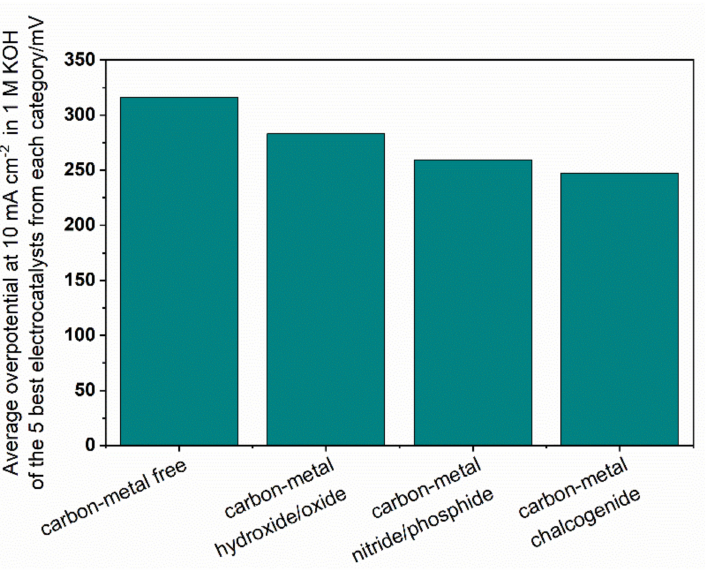
Figure 8. Average overpotentials at 10 mA cm − 2 of the five best carbon-based electrocatalysts reviewed from each category in 1 M